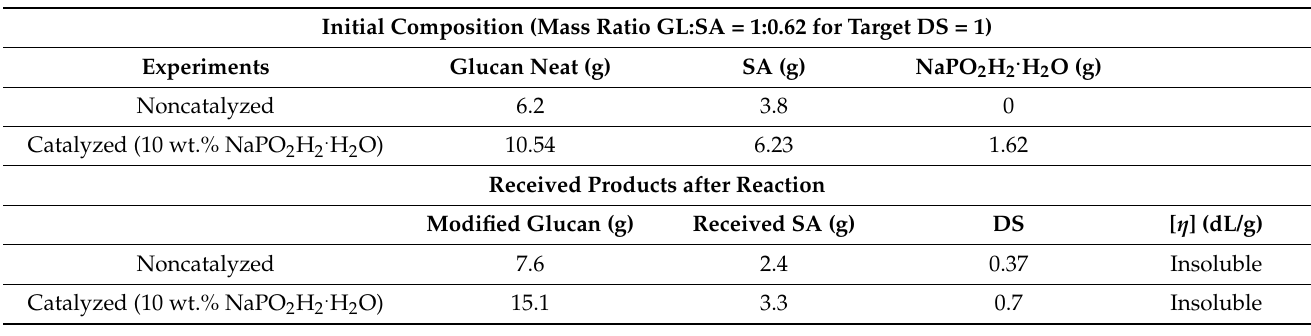
Table 2. Reaction data for laboratory-scale modification of the α -(1,3) glucan with succinic anhydride.